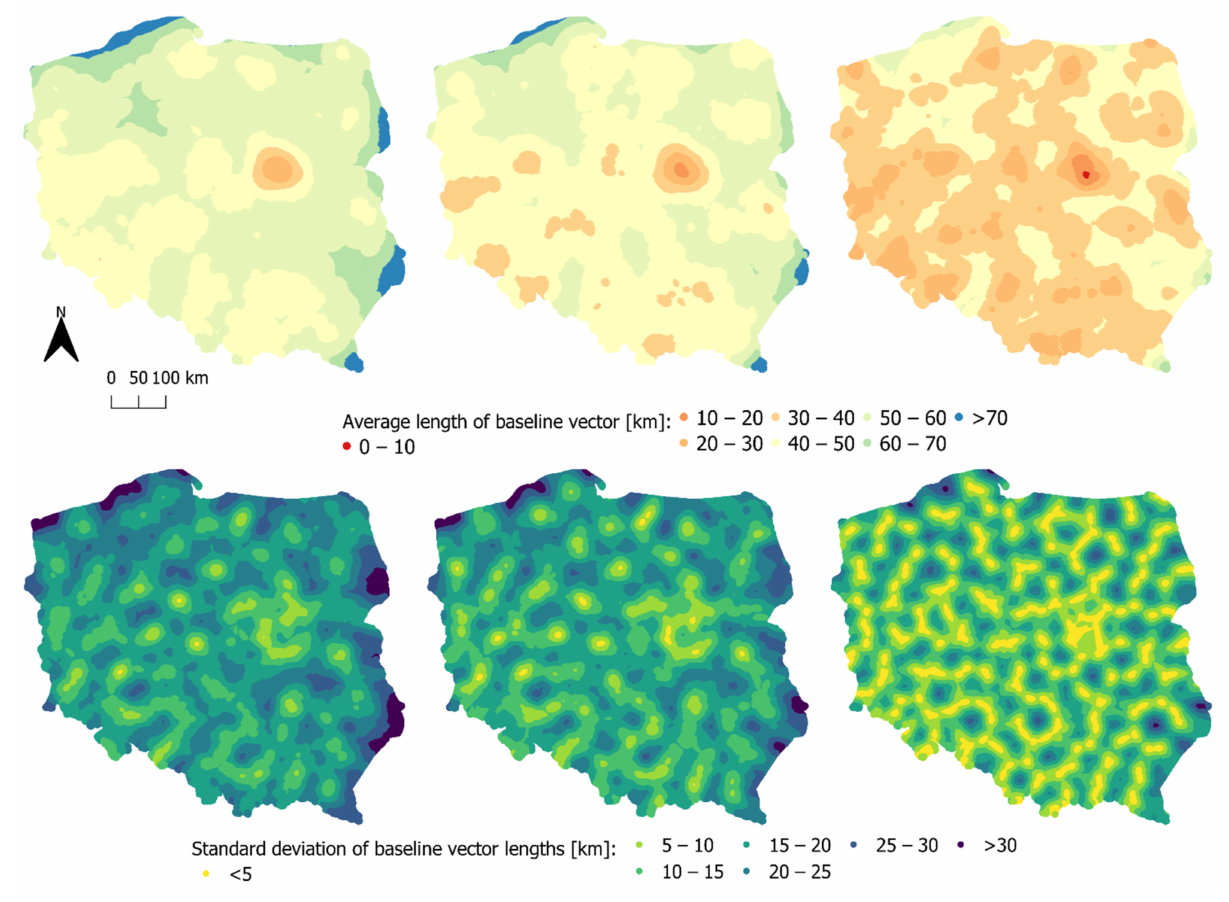
Figure 4. Division of Poland regarding the mean baseline vector length and standard deviation. Mean baseline vector length to the six, five, and three nearest ASG-EUPOS stations (left to right).